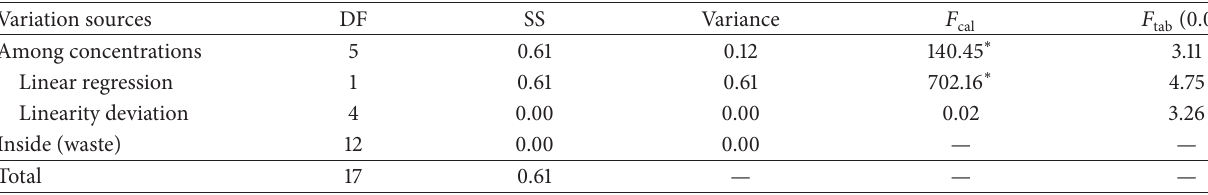
Table2:Analysisofvarianceoftheabsorbancevaluesdeterminedinobtainingoftheanalyticalcurvesofstandardrifaximin,usingabsorption spectrophotometry method in the ultraviolet